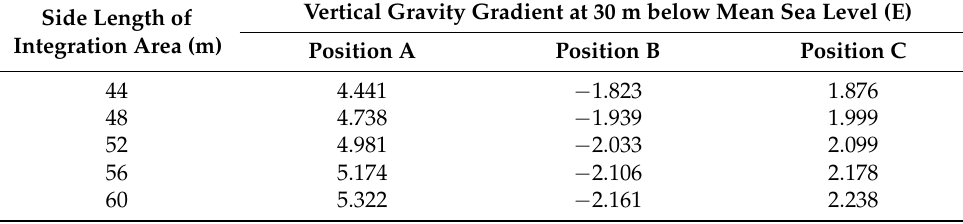
Table 3. Variation of gradient with integration range at 30 m below mean sea level. Side Length